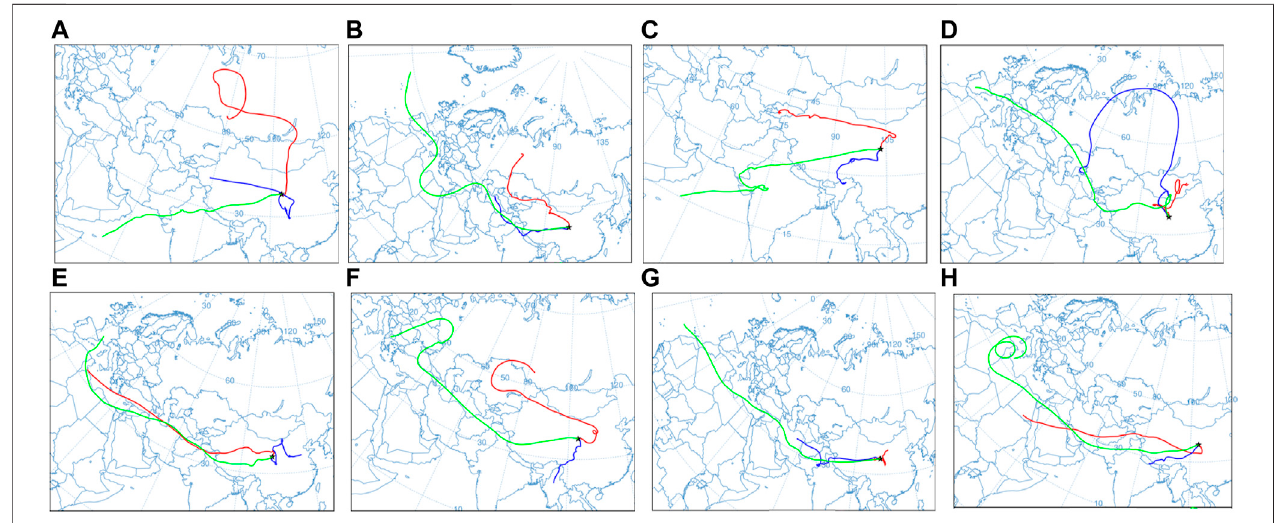
Frontiers in Environmental Science |